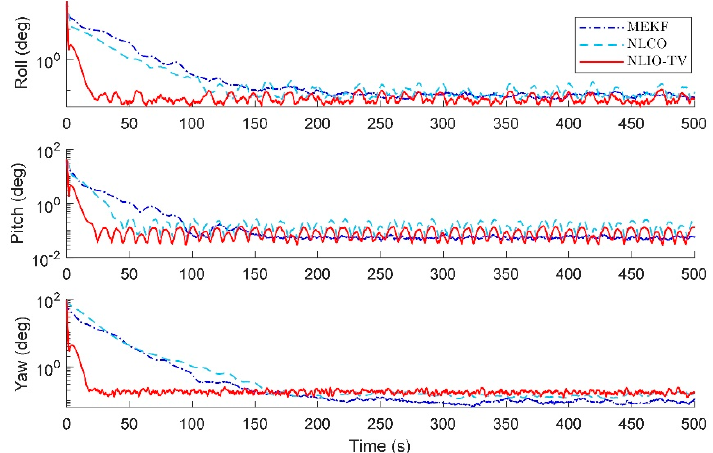
Figure 14. Averaged absolute attitude estimation error over 100 simulations.